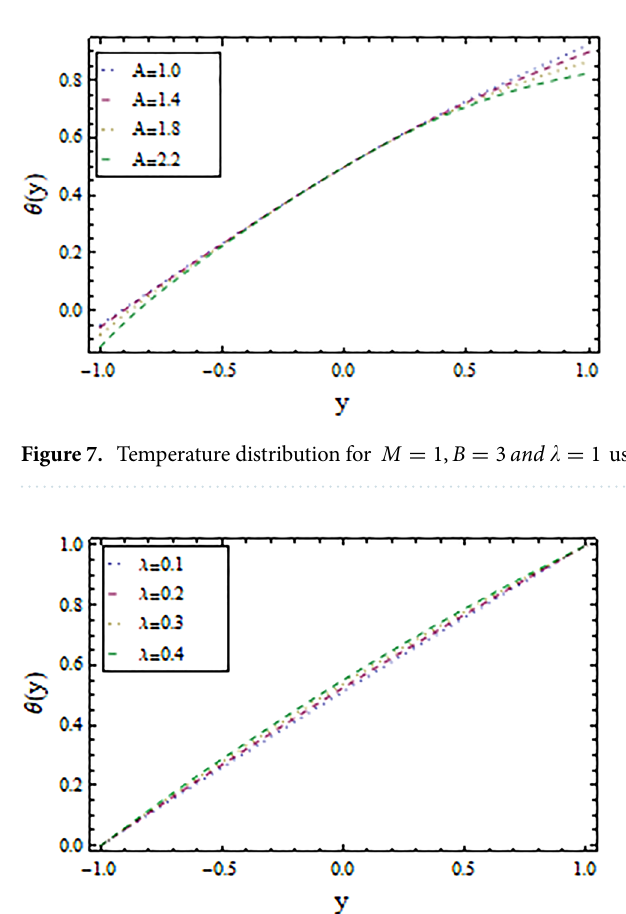
Figure 6. Temperature distribution for M = 1, B = 3 and (cid:31) = 1 using OHAM.